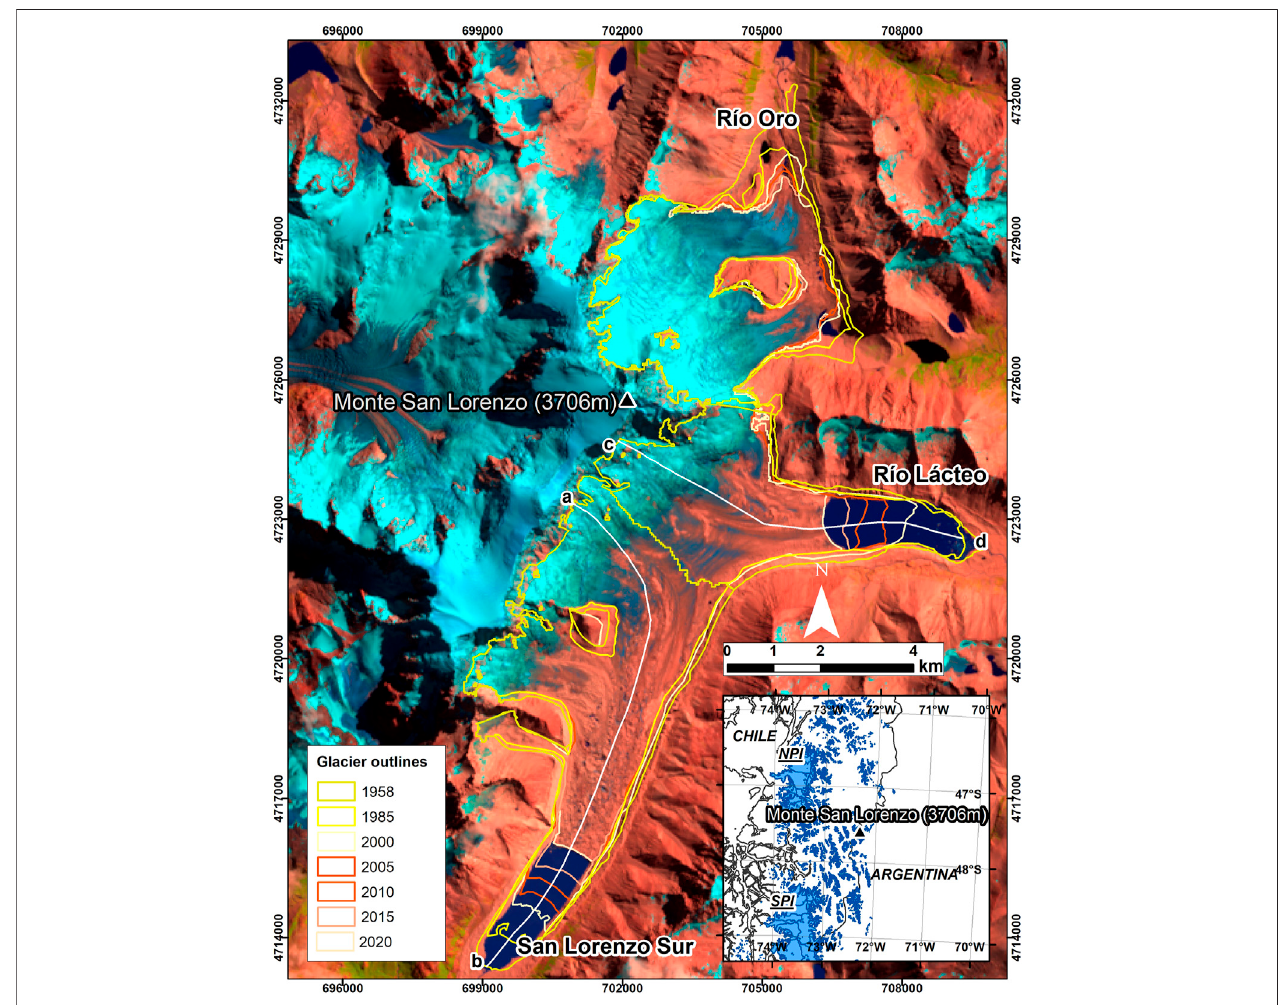
FIGURE 1 | View of the investigated glaciers in the Monte San Lorenzo and location of the study area in relation to the Northern (NPI) and Southern Patagonian Ice fi elds (SPI). Coordinates are UTM WGS84 Zone 18 S. a – d are the surface velocity pro fi les detailed in Figure 5 .